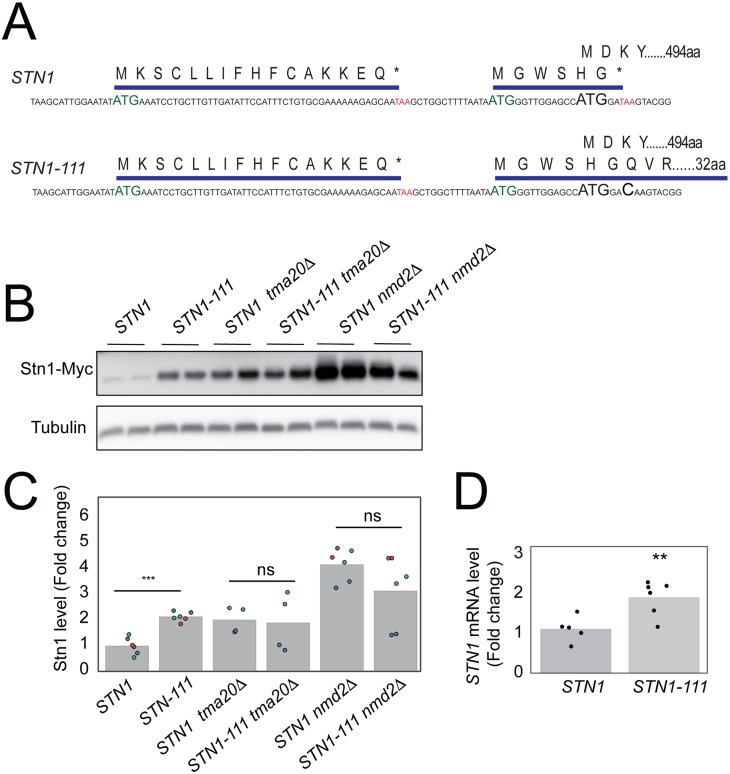
The STN1 oORF termination codon affects Stn1 levels.A) STN1-111 is a point mutation in the termination codon of the natural oORF, extending the oORF from 6 to 32 aa. B) Western blot analysis of Stn1-Myc and tubulin levels. C) Quantification of western blot in B and S9 Fig. The points on the graph represent independent measurements, and points in the same colour are from the same western blot. D) STN1 transcript levels were measured as in Fig 1E (**) P < 0.01.